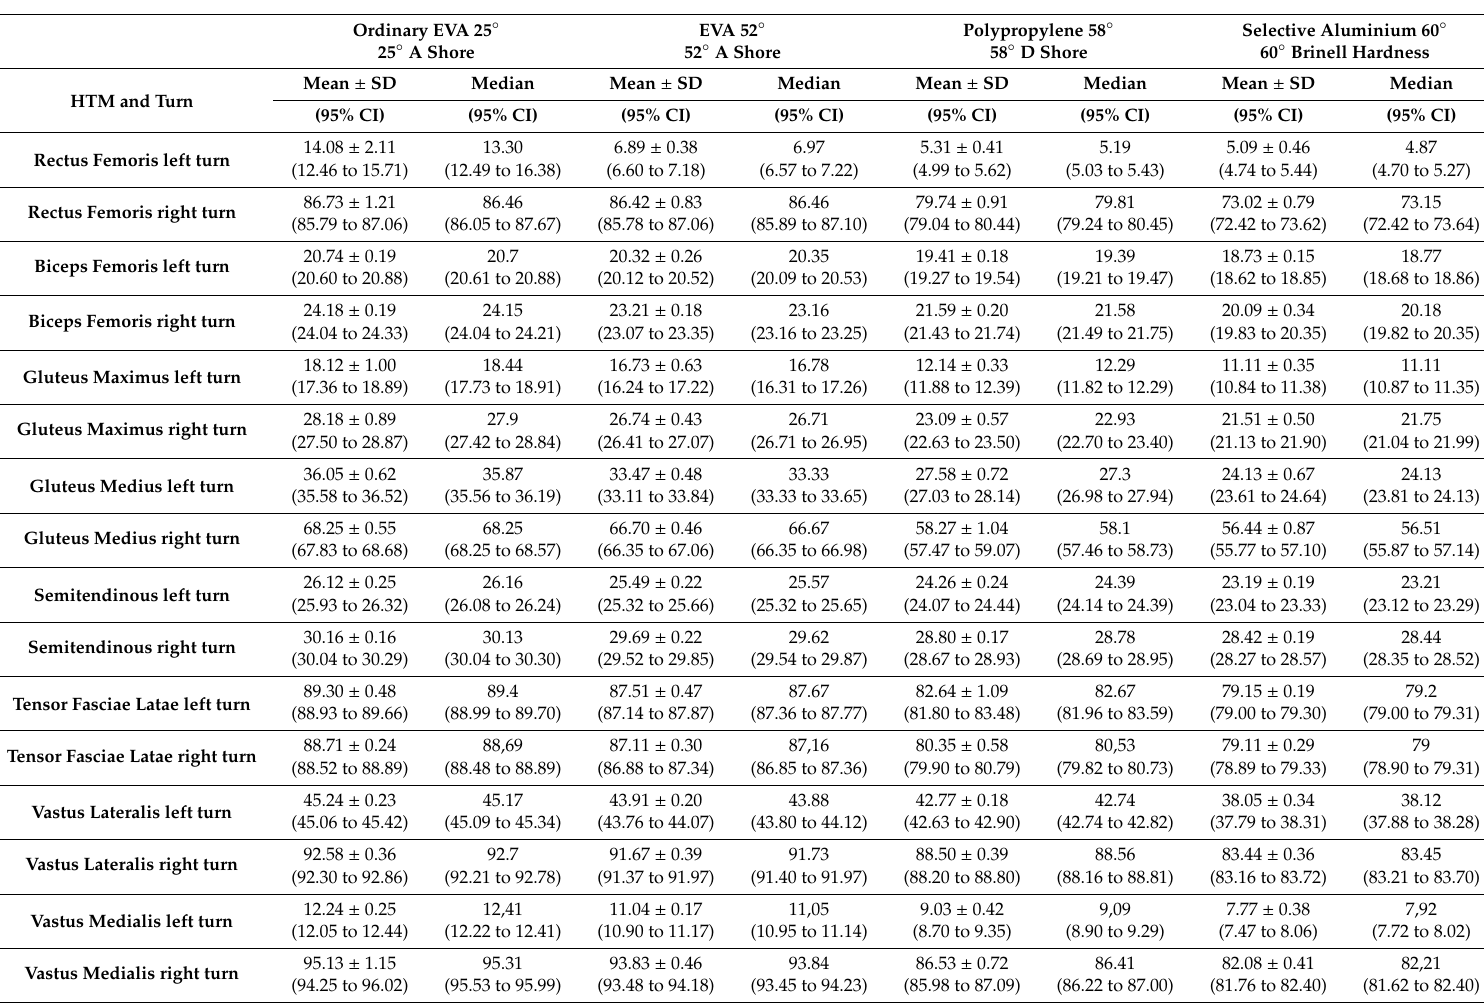
Table 4. Measurement of the Peak amplitude of the electromyographic patterns of the Thigh and Hip muscles for di ff erent HI for left and right turns on the